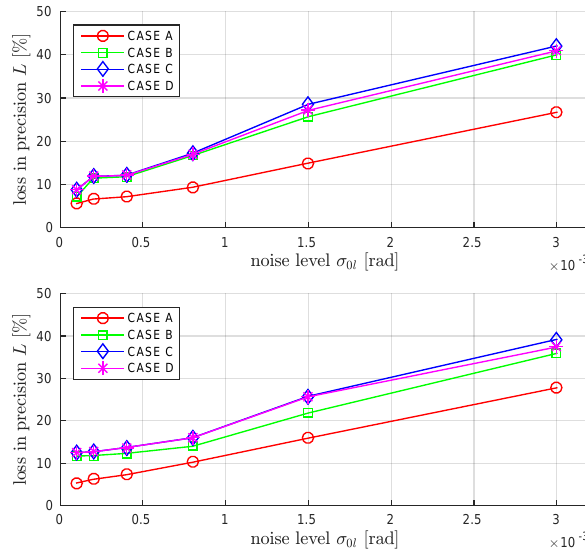
Figure 8. The loss in accuracy L C in percent of ASE approximations C ASE A-D compared to ideal solution at different noise levels σ 0 l in radian on dataset B UILDING (top) and F IELD (bottom).